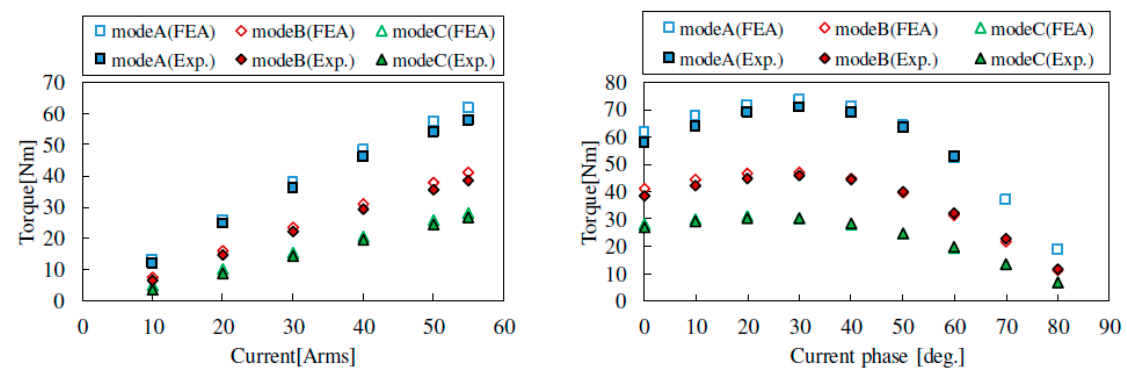
Figure 18. Measured and analyzed output torque in each mode. Left shows the current vs. torque and right shows the current phase vs. torque when current is 55 Arms.